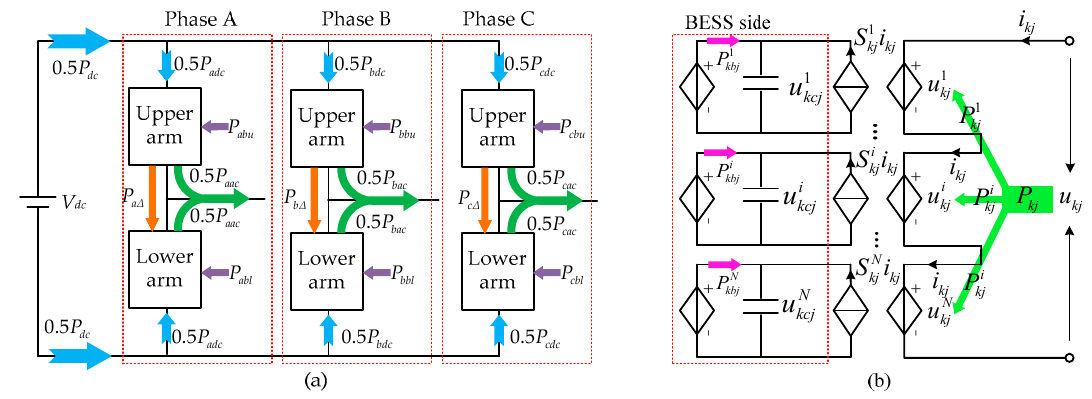
Figure 2. Power flow of MMC-BESS: ( a ) power flow among phases and between arms; ( b ) power flow among submodules within arms.